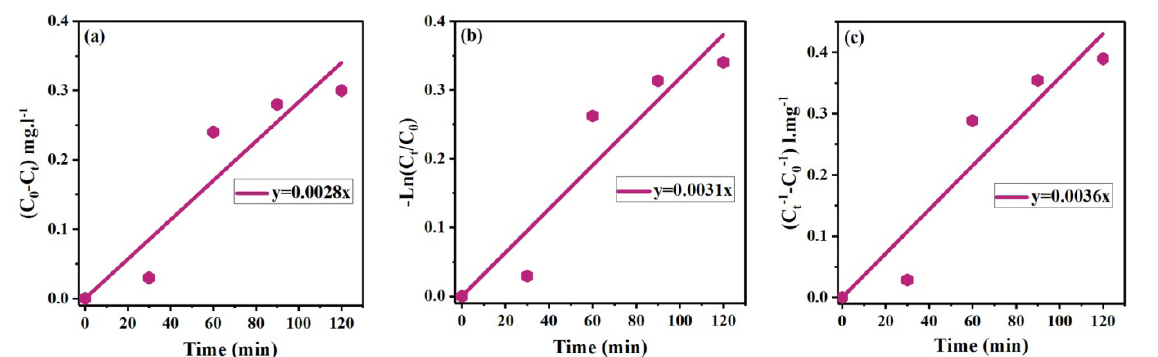
O /CeO /Ag CNPs 2 3 2